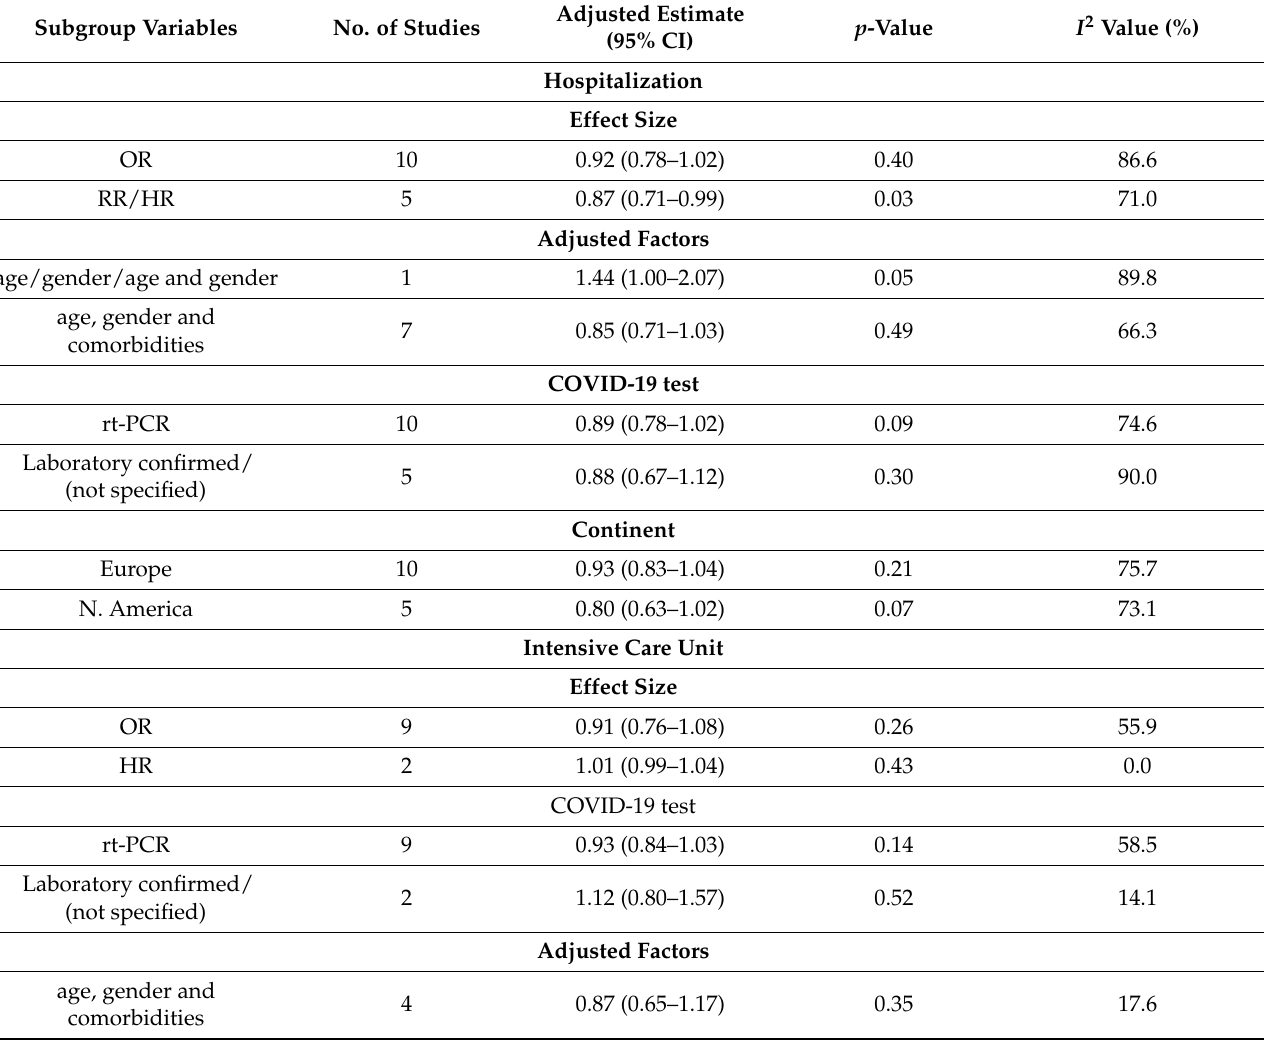
Table 6. Subgroup analysis of the association between influenza vaccination and COVID-19 clinical